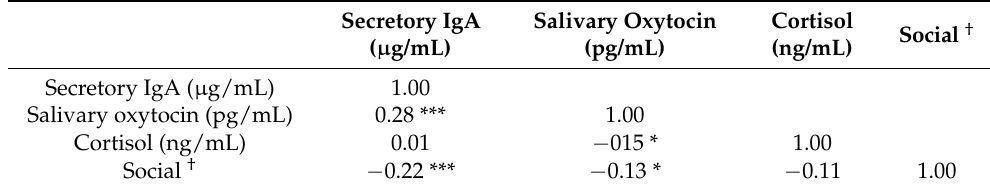
Table 3. Correlation matrix of secretory immunoglobulin A, salivary oxytocin, and serum cortisol in bull Asian elephants during socialization of two all-male